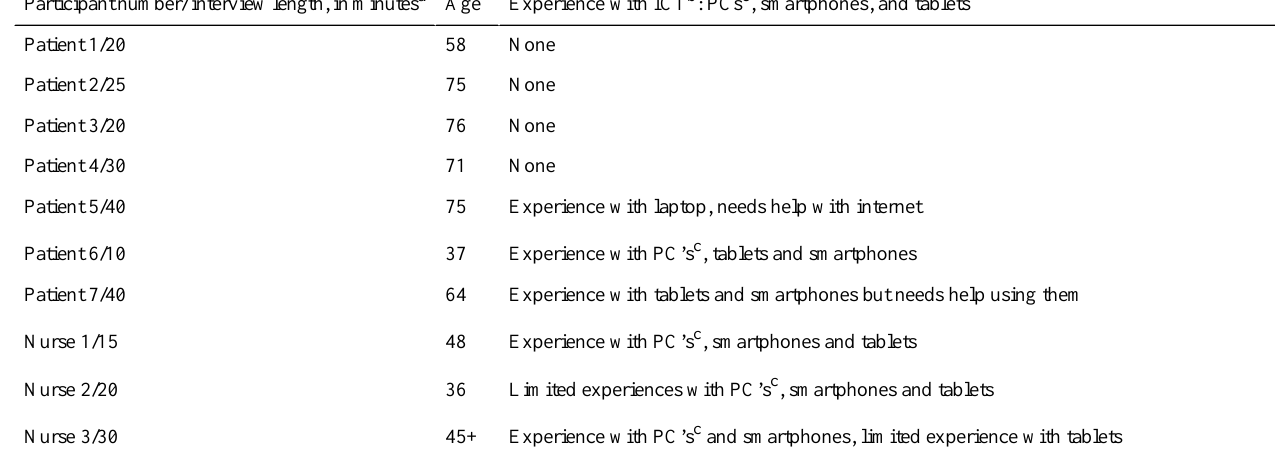
Table 1. Participant